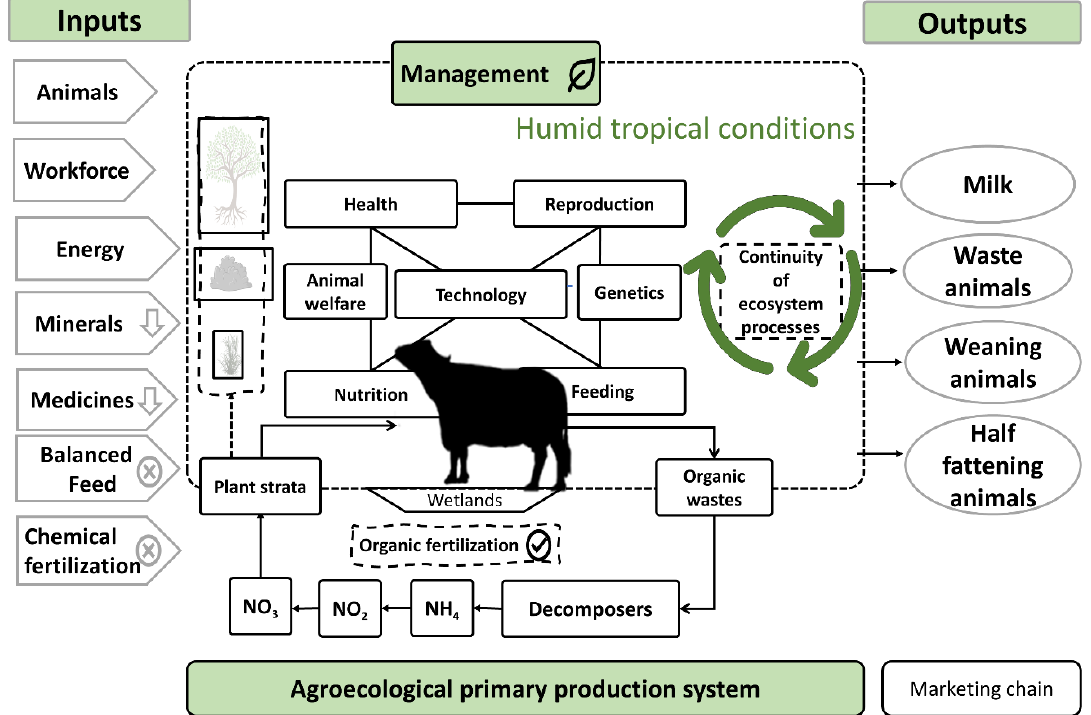
Figure 2. Agroecological conception of dual-purpose production systems with river buffaloes in conditions of the humid tropics.